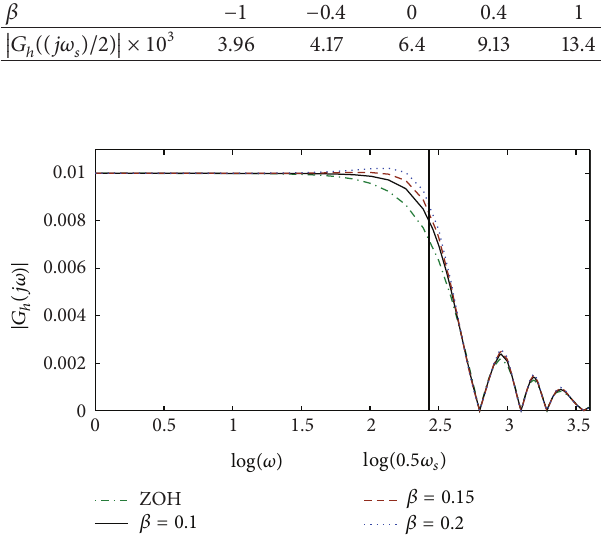
Figure 5: Amplitude of the frequency responses of ZOH and FROH for small 𝛽